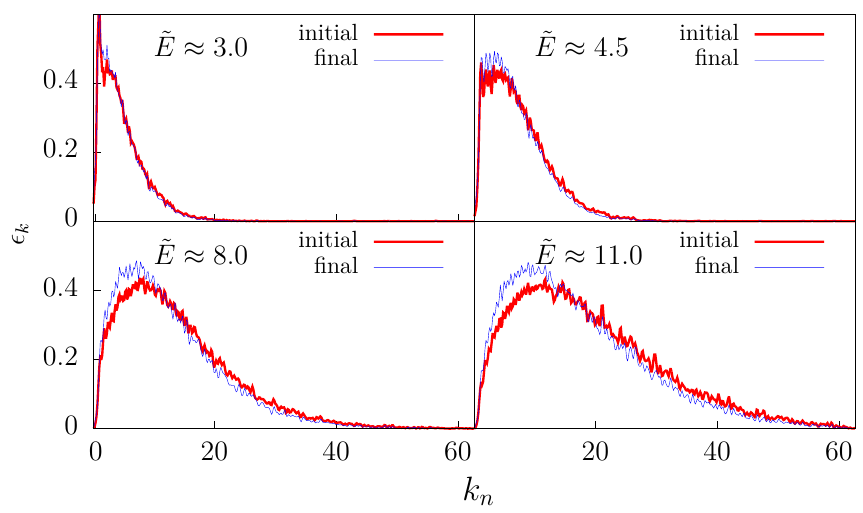
Figure 5 . The distributions of energy over the modes (cid:15) k per wave number for the initial (red, thick line) and (cid:12)nal (blue, thin line) wave packet for the boundary solutions from (cid:12)gure